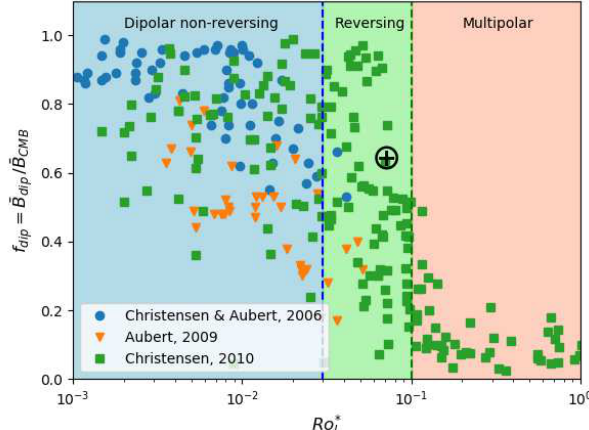
Figure 3. Values of f dip for numerical dynamos. Data are from Chris- tensen and Aubert (2006); Aubert et al. (2009), and Christensen (2011b) repectively. Colored regions corresponds to the different dynamo regimes. The value for the Earth is shown as ⊕